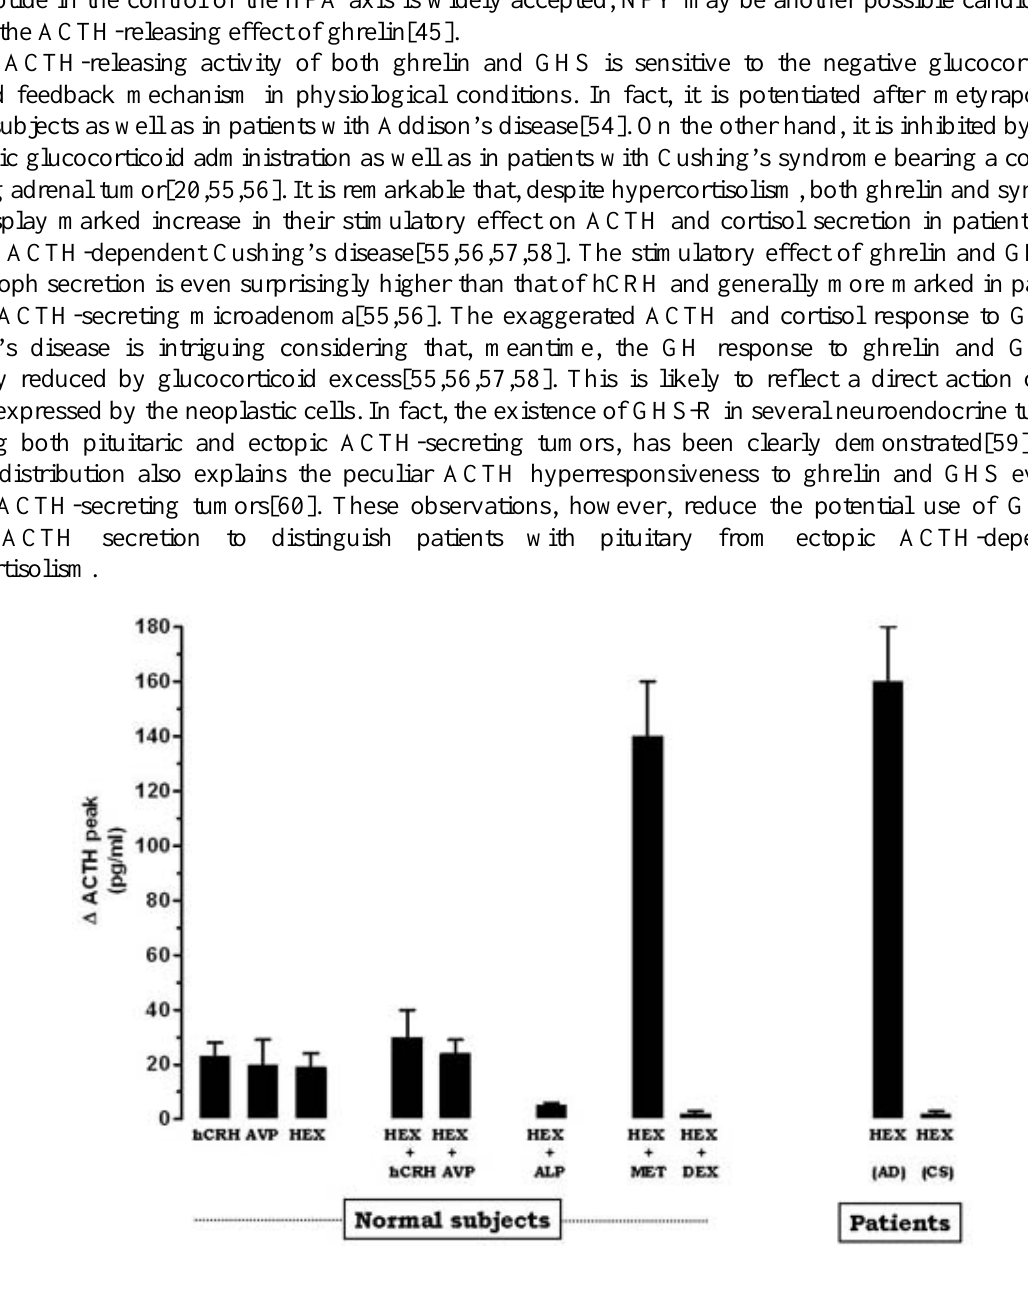
FIGURE 3. ACTH responses ( Δ peak, mean ± SEM) to hCRH (2.0 µg/kg i.v. at 0 min), AVP (0.17 U/kg i.m. at 0 min), hexarelin (HEX, 2.0 µg/kg i.v. at 0 min), HEX + hCRH, HEX + AVP, HEX + alprazolam (ALP, 0.02 mg/kg p.o. at –90 min), HEX + metyrapone (MET, 0.04 g/kg p.o. at 2300 h on the previous night), HEX + dexamethasone (DEX, 1 mg p.o. at 2300 h on the previous night) in normal subjects, and to HEX in patients with Addison’s disease (AD) and Cushing’s disease